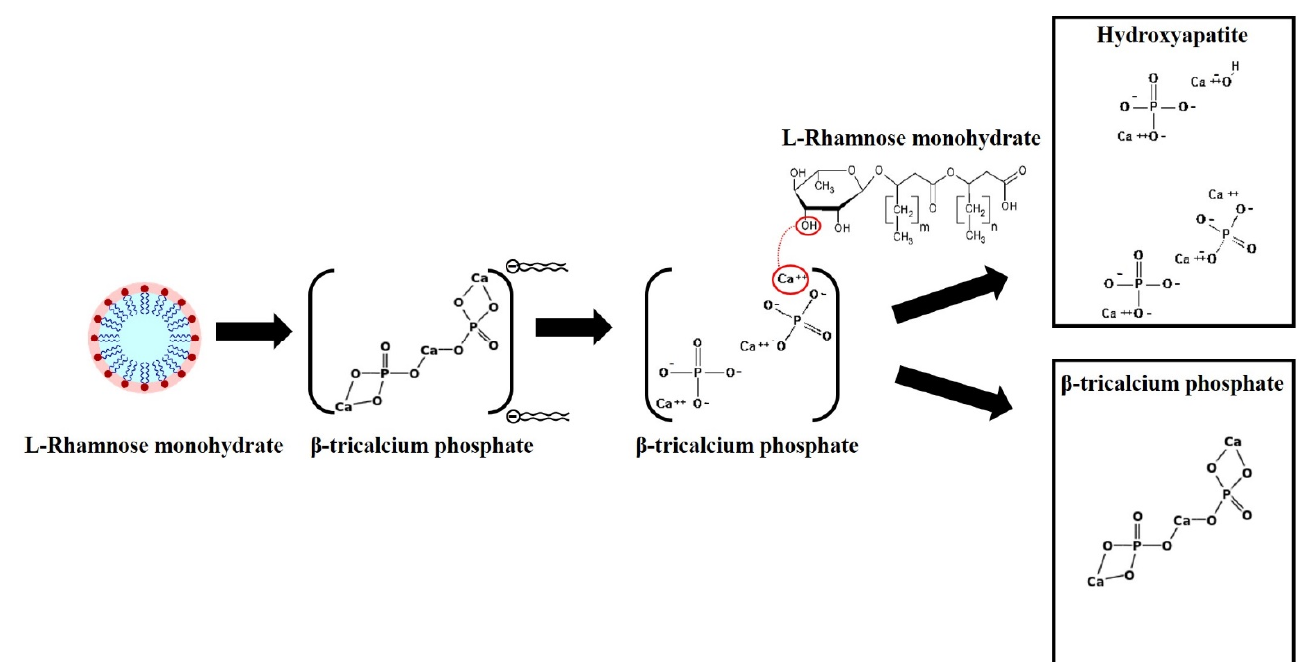
Figure 1. Schematic diagram of biphasic calcium phosphate synthesized by a hydrothermal reaction using L-rhamnose monohydrate as a biosurfactant.